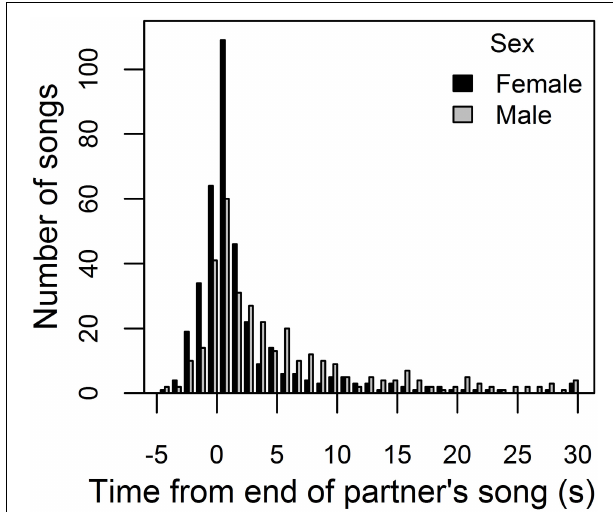
FIGURE 3 | Distribution of female and male response intervals. Frequency histogram of response intervals: time between the start of a female (male) song and the end of the preceding male (female) song, shown in black (gray). Labels on the x-axis indicate upper bounds of 1-s bins. Intervals less than zero indicate that the female (male) overlapped their partner’s song, commencing a song while their partner was singing. The plot excludes response intervals greater than 30s (that represent 7% of female and 14% of male response intervals).